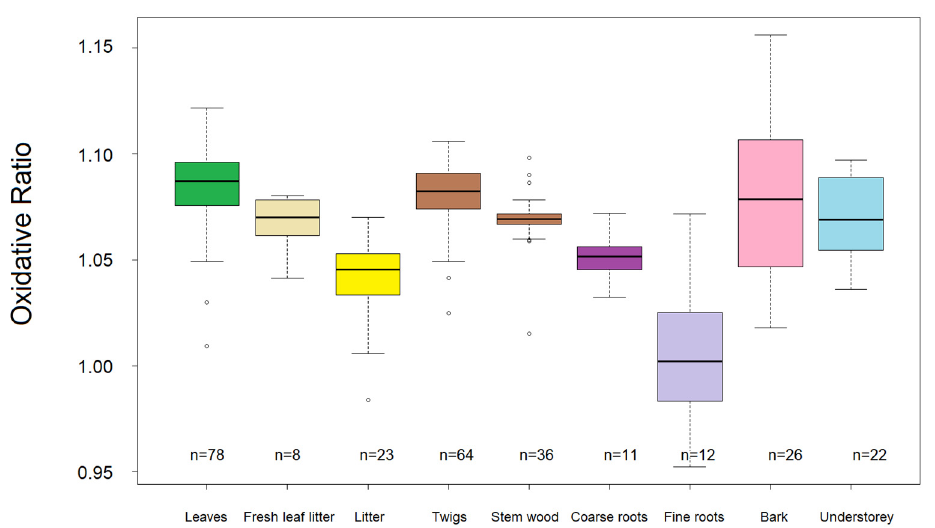
Figure 2. Boxplots of the main ecosystem component oxidative ratios at the Leinefelde field site, independent of sampling time or height. Table 3. C/N, C/O, C ox , and OR of the ecosystem components independent of time (mean with standard error SE). Fresh leaf litter are leaves collected from the ground in October, still green in color, while litter is the deposited organic material (leaves, twigs, seeds) on the forest floor. Fine roots and coarse roots are not specifically from the beeches, but a mix of unidentified species. 1 The biomass data are for branches and twigs [25], while the collected samples are twigs. The biomass share of only twigs is not known. Stem wood includes 6 samples from May and October 2019, as well as from the 2020 stem core sampling.